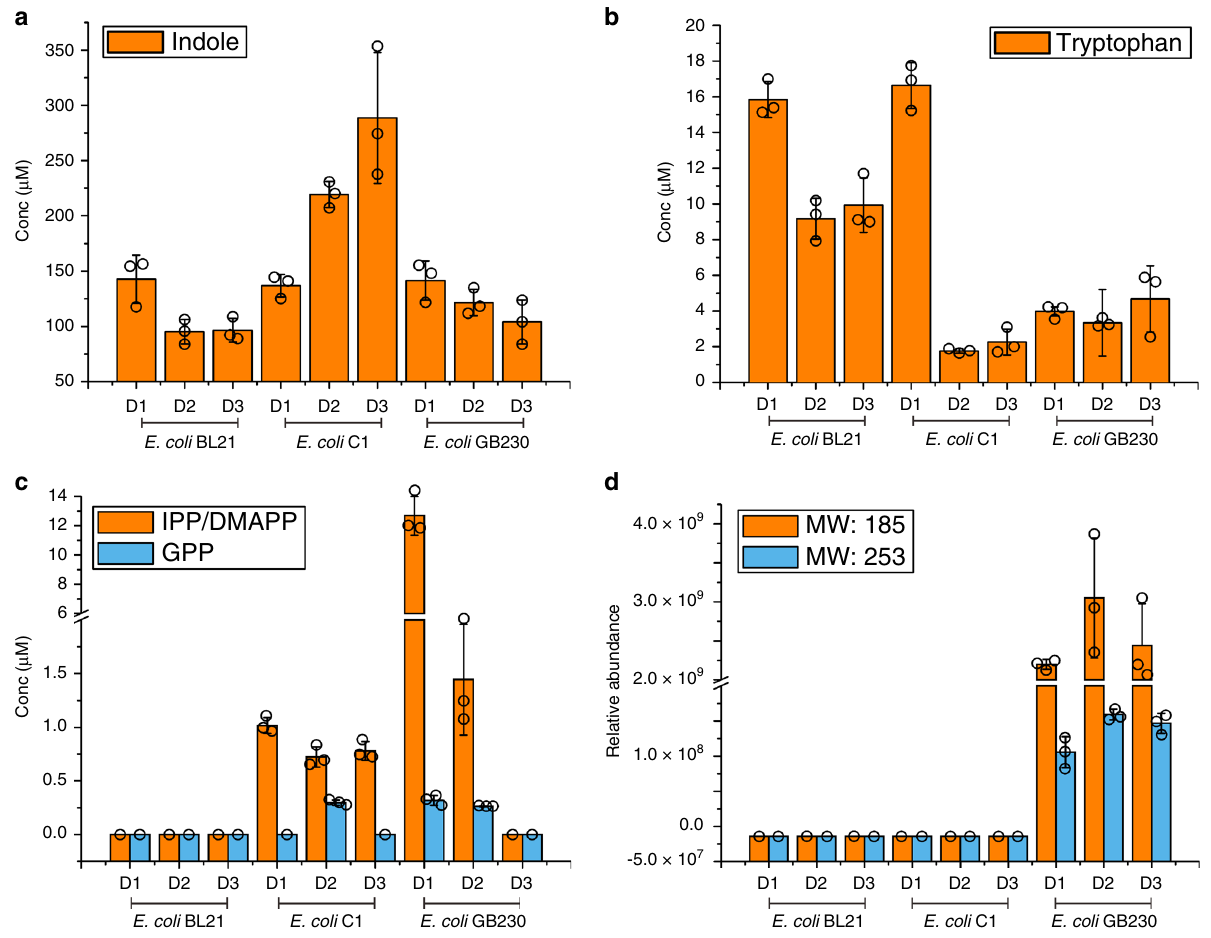
Fig. 3 Accumulation of compounds in engineered E. coli strains. Plates a – d represent the accumulation of ( a ) indole, ( b ) tryptophan, ( c ) IPP/DMAPP and GPP, and ( d ) prenylindoles in E. coli BL21(DE3), E. coli C1 (with overexpressed heterologous mevalonate pathway), and E. coli GB230 (with Idi, FPPS and AaTPS overexpressed in E. coli C1). Cells were harvested at 24, 48, and 72 h after IPTG induction. Cells of each engineered strain were harvested (5 × 10 6 cells, ~0.02 g dry cell weight) and extracted with 300 μ L extraction solution (methanol:acetonitrile:water = 2:2:1). The organic layer was analyzed by LC- MS/MS and product quantities were averaged for four independent experiments. Conc represents the concentration of compounds detected in E. coli . Error bars indicate the standard deviations of three biological replicates. Source data are provided as a Source Data fi